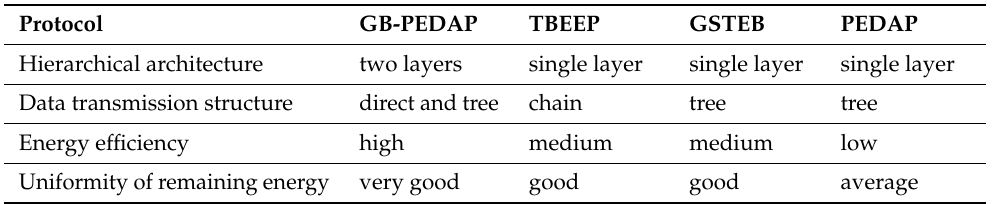
Table 2. The comparisons among different data aggregation protocols.